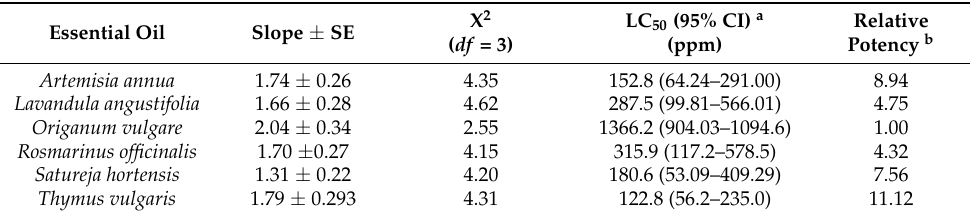
Table 2. Estimated LC 50 values and relative potencies of six essential oils on Xanthogaleruca luteola eggs after 72 h of exposure.